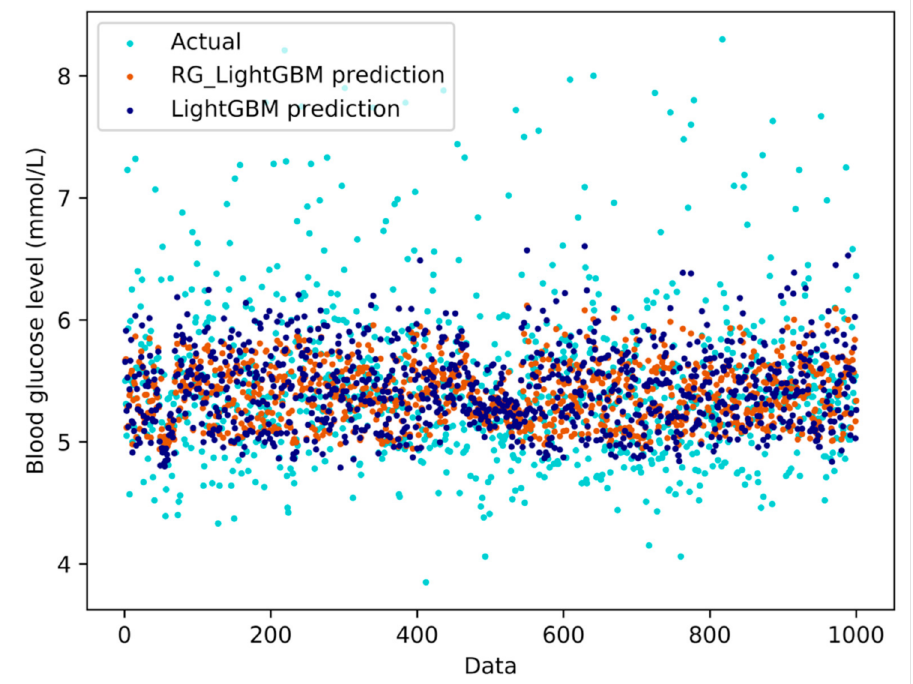
Figure 15. The scatter plot diagram of the actual and predicted blood glucose (fasting/pre-prandial) levels by the RG_LightGBM and LightGBM